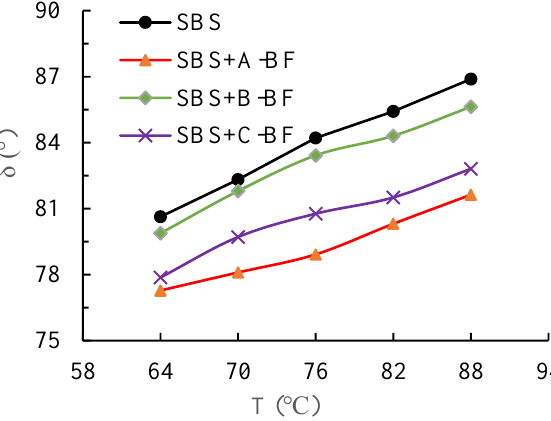
Figure 6. Results of the phase angle.